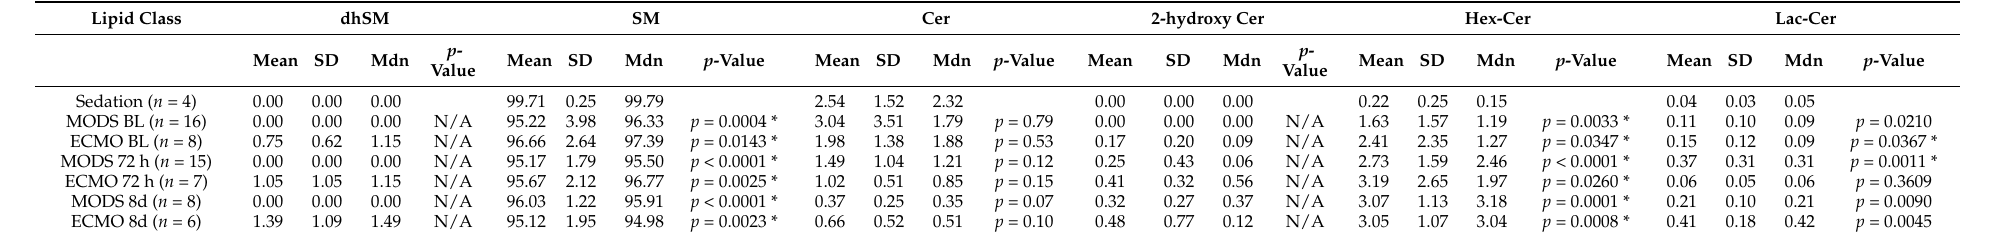
Table 2. Percent total sphingolipids of MODS/ECMO Study 2016–2018 ( N =